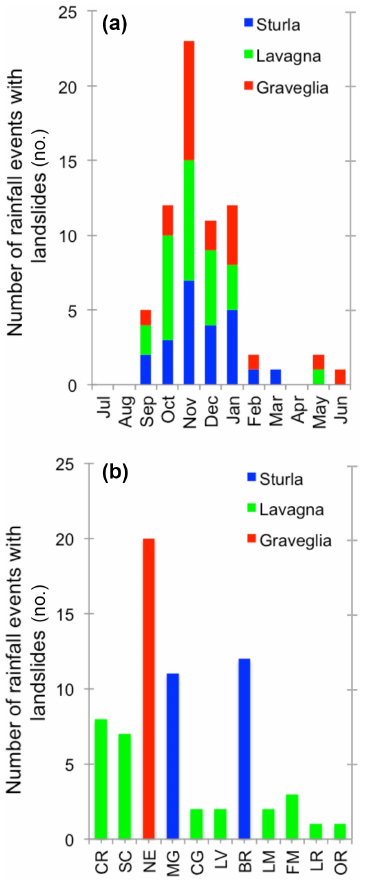
Figure 6. (a) Seasonal and (b) geographical distribution of rain- fall events with landslides in the 15-year period 2002–2016 in the Lavagna, Graveglia and Sturla tributary valleys of the Entella catch- ment. Landslide sites: BR – Borzonasca; CG – Cicagna; CR – Carasco; FM – Favale di Malvaro; LM – Lumarzo; LR – Lorsica; LV – Leivi; MG – Mezzanego; NE – Ne; OR – Orero; SC – San Colombano Certenoli. See Fig. 1 for location of the landslide